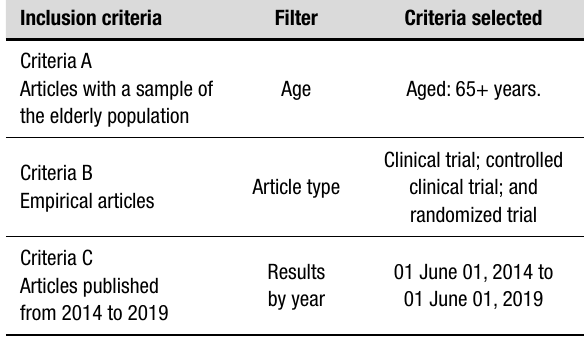
Table 1. Inclusion criteria and filters for the selection of articles. Inclusion